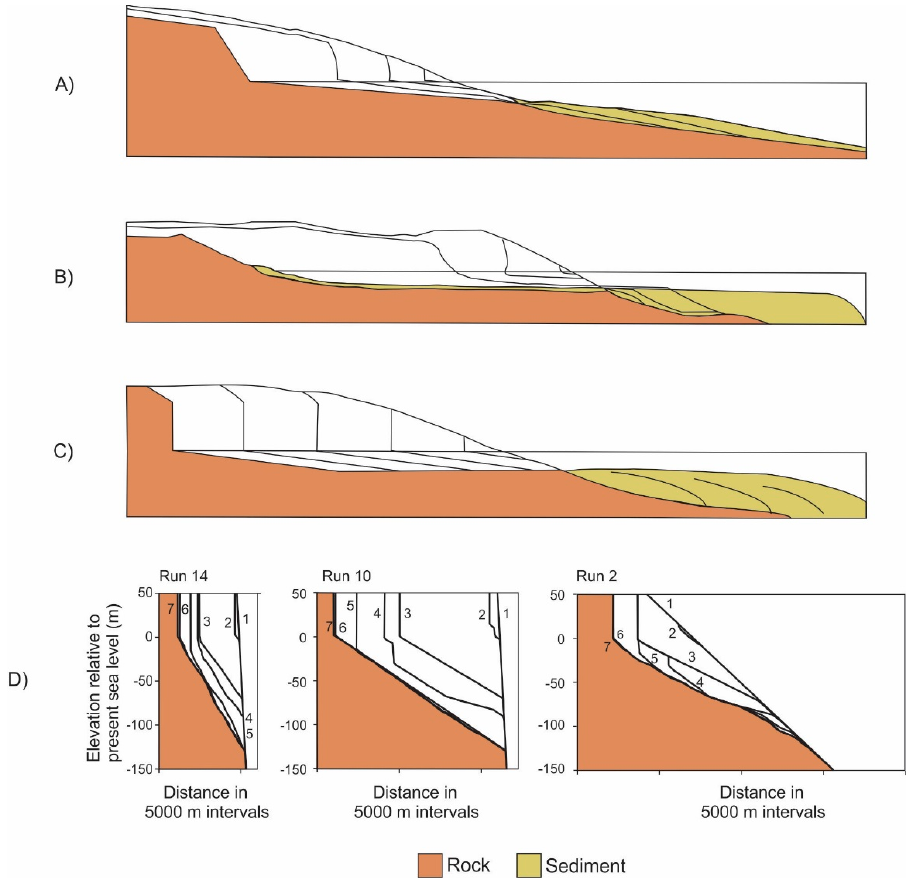
Figure 2. Models of hard rock coastal evolution with stable sea level according to: ( A ) Davis [13]; ( B ) Johnson, [12]; and ( C ) Challinor [15]. ( D ) Examples of model runs (run parameters are listed in the original article) examining the evolution of hard rock coastal profiles with changes in sea level on tectonically stable landmasses. Labels 1 to 7 alongside each profile refer to 5.4, 3, 2, 1, 0.5, 0.125, and 0 million years ago, respectively [31].